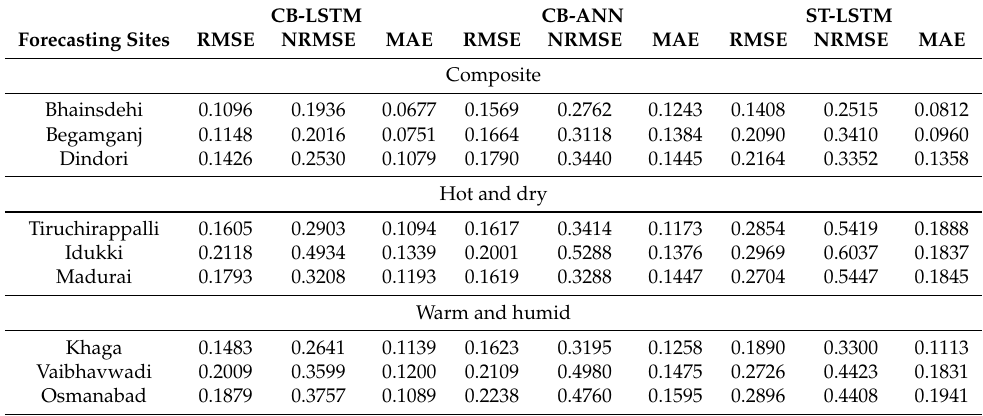
Table 7. Forecasting performance of CB-LSTM compared to multivariate and spatiotemporal LSTM. CB-LSTM CB-ANN ST-LSTM Forecasting Sites RMSE NRMSE MAE RMSE NRMSE MAE RMSE NRMSE MAE Composite Bhainsdehi